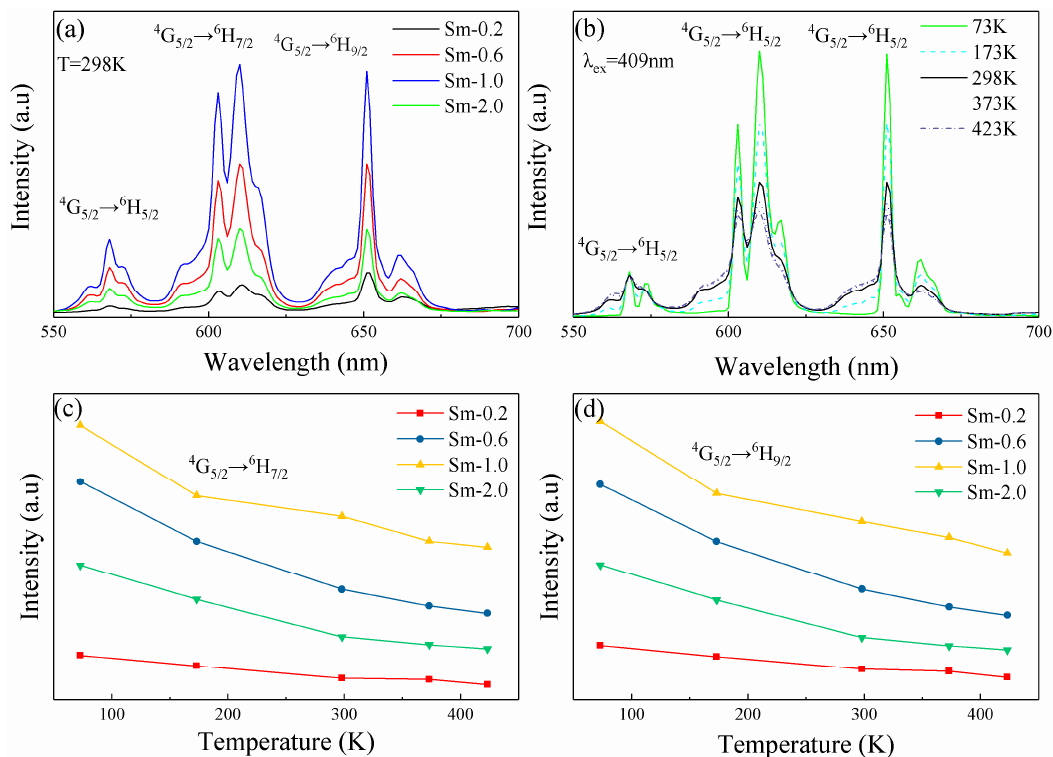
Figure 4. ( a ) The emission spectra of various concentration Sm:LN single crystals. ( b ) The emission spectra of 1.0 mol.% Sm:LN single crystals under series temperature. ( c ) The fluorescence intensity peaks of 4 G 5/2 → 6 H 7/2 corresponding to wavelength center 610 nm. ( d ) The fluorescence intensity peaks of 4 G 5/2 → 6 H 9/2 corresponding to wavelength center 651 nm.